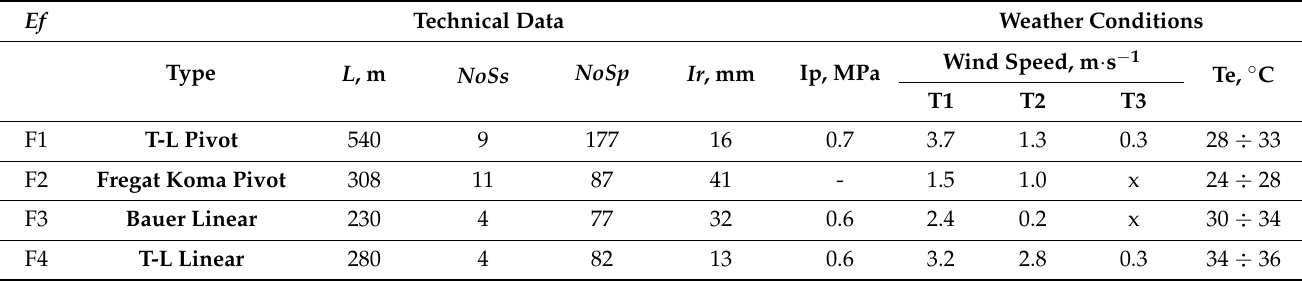
Table 2. The irrigation machine technical data and other